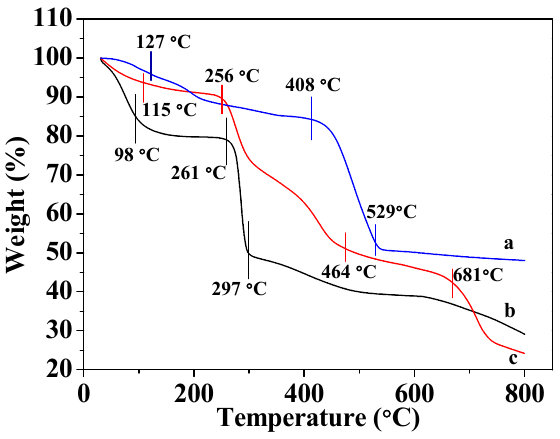
Figure 2. Thermogravimetric analysis (TGA) traces for (a) MOF-5, (b) MOF-5–CMC, and (c) CMC (The TGA conditions were gas flow 100 mL/min; atmosphere, air; temperature ramp, 10 °C/min.)